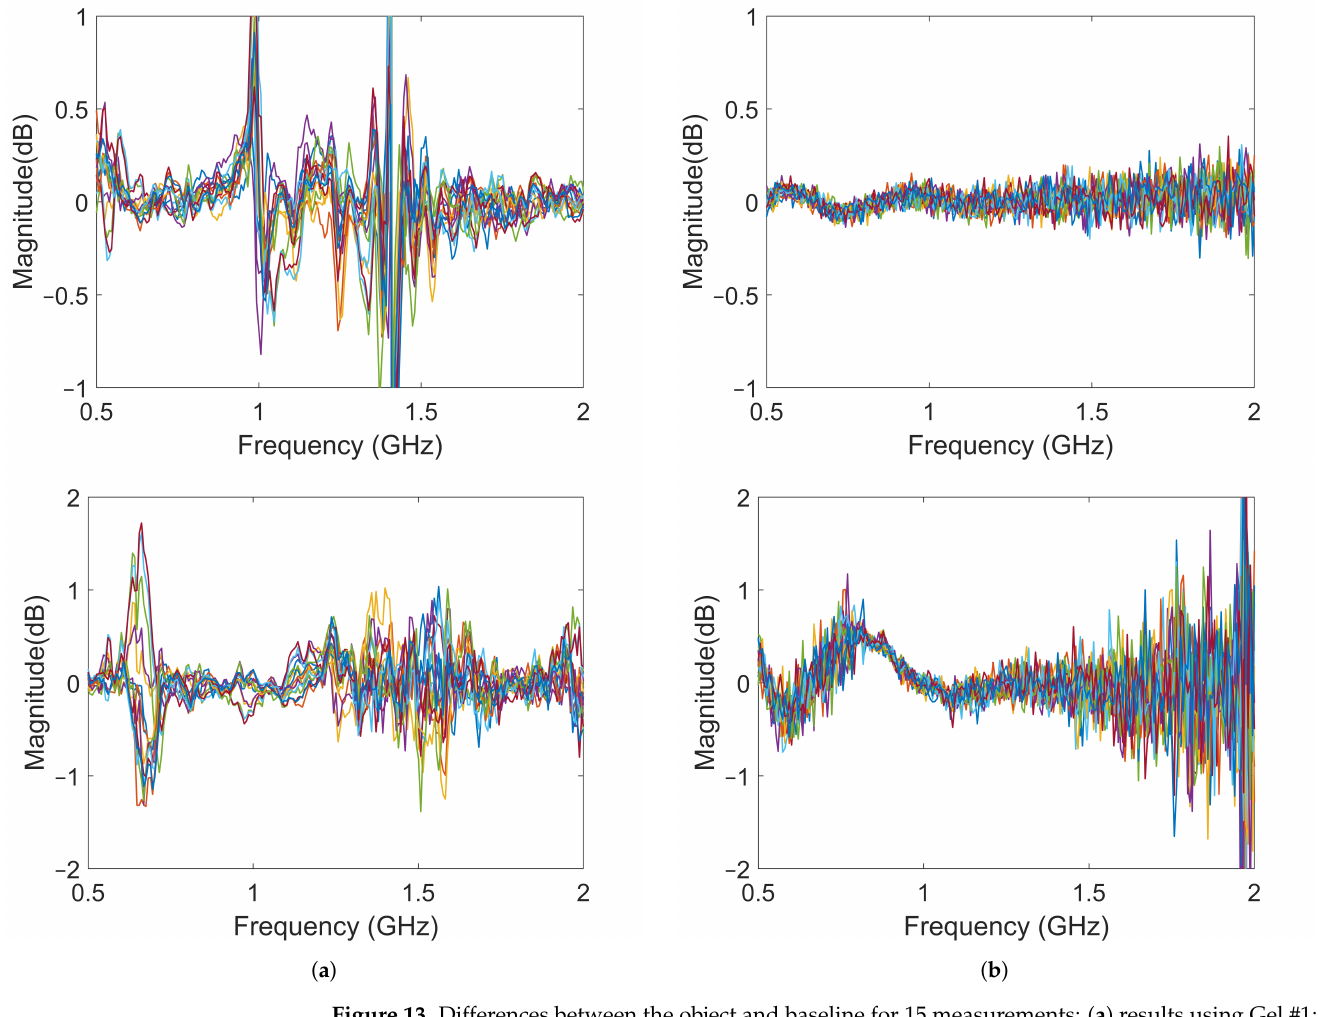
Figure 13. Differences between the object and baseline for 15 measurements: ( a ) results using Gel #1; ( b ) results using Gel #3. The upper images show the results for S21 and the lower images show the results for